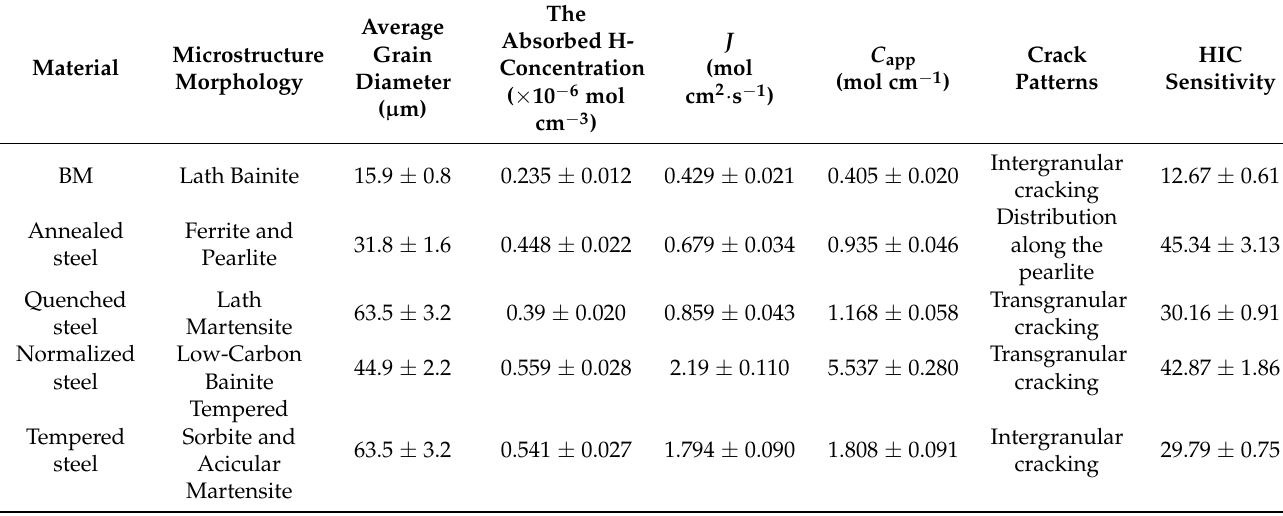
Table 1. Microstructure characteristics, test data, and cracking characteristics for BM and the heat treatment microstructure.